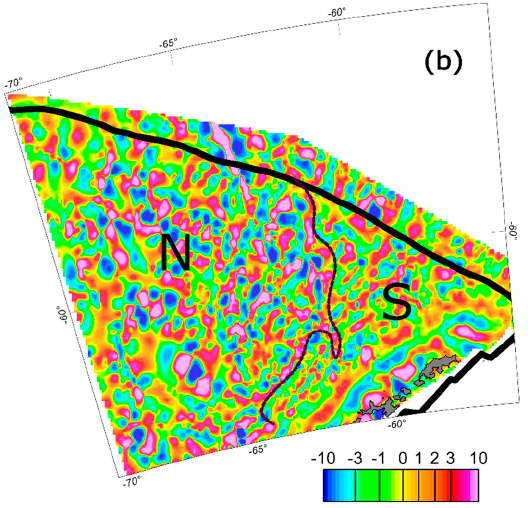
Figure 5. ( a ) Crustal magnetization map obtained after a bandpass filter with long and short wave- length cutoffs of 200 km and 7 km. Two thick black dotted lines denote the Shackleton Fracture Zone (SFZ) and the Hero Fracture Zone (HFZ). Two white solid lines separate P1, P2, and P3 zones. R1, R2, and R3: ridges locations. Thin black dotted lines perpendicular to P1, P2, and P3 denote the location of the central normal polarity segments according to [5,9,10]. C4 and C5: Chrons of seafloor spreading magnetic anomalies. The white dotted ellipse denotes a normal magnetization alignment (see text for details). Black solid polygon indicates NW–SE alignment (see text for details). Black dotted polygon indicates positive magnetization area (see text for details). The magnetization of the South Shetland archipelago block is marked with a black dashed-dotted polygon. ( b ) Crustal magnetization map obtained after a bandpass filter with long and short wavelength cutoffs of 100 km and 7 km, respectively. Black line delimits two areas labeled as N and S (see text for comments). Both areas differ in orientation and in amplitude of the magnetization signals. Plate boundaries are denoted by black solid thick